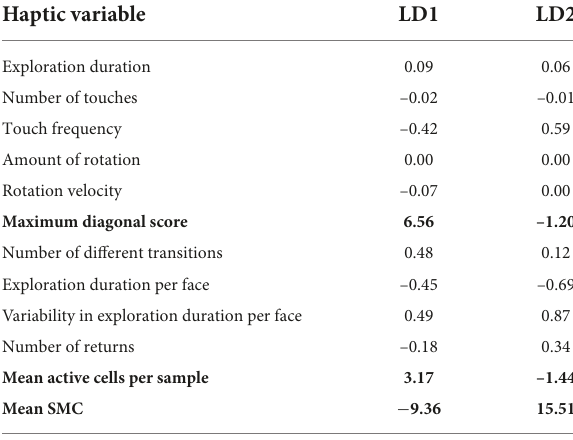
TABLE 2 Coefficients of linear discriminants